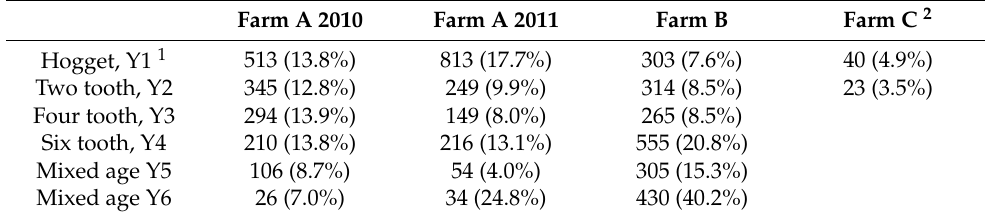
Table 5. Annual dead/missing incidence (a proxy for annual mortality): of the ewes that remained in the cohort at the start of each production year (pre-mating), the number (and %) of ewes that exited due to dead/missing, for each study cohort.